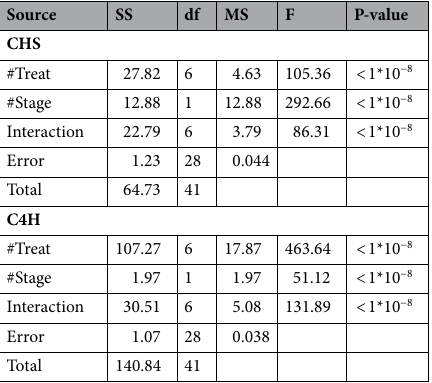
Table 1. The results of two-way analysis of variance for comparing the expression of target genes in the aerial part under different hormonal treatments at different phenological stages.